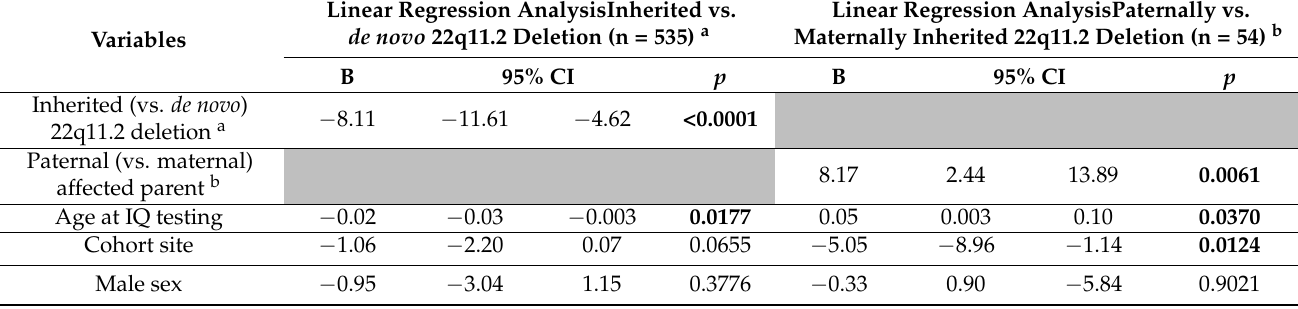
Figure 2. Individuals with inherited deletions of maternal origin were found to have a lower median FSIQ than those of paternal origin.